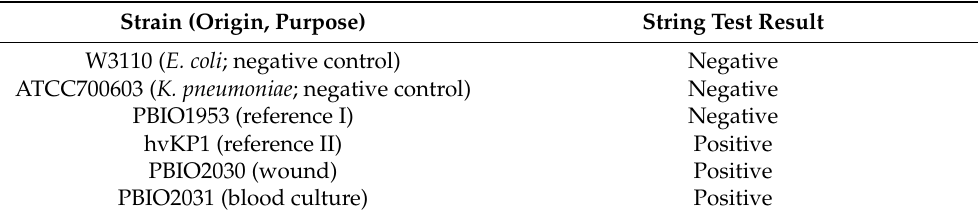
Table 1. Results of string test. A positive result is given at a string length ≥ 5 mm. Strain (Origin, Purpose) String Test Result W3110 ( E. coli ; negative control) Negative ATCC700603 ( K. pneumoniae ; negative